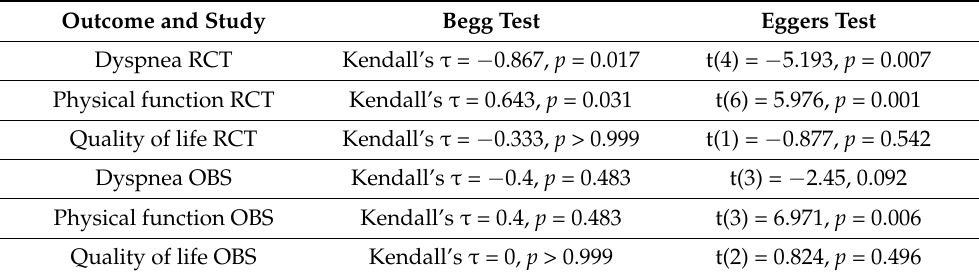
Table 5. Begg and Egger tests for publication bias.